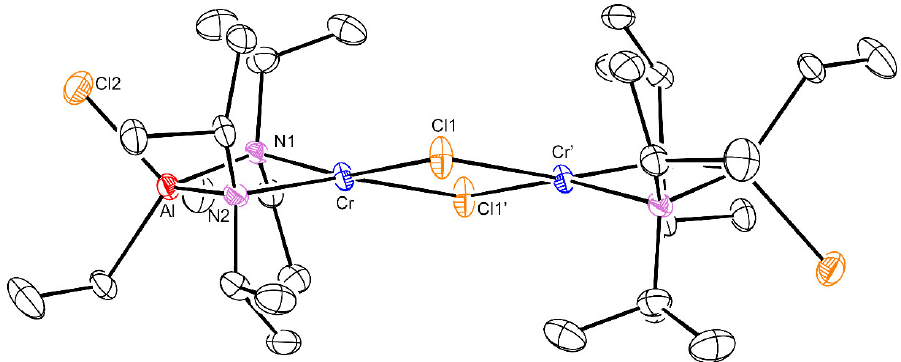
Figure 6. X-ray structure of [{Et(Cl)Al(N(iPr) 2 ) 2 }Cr(μ-Cl)] 2 . Selected bond distances (Å) and angles (°): Cr-Cl1, 2.4212; Cr-N1, 2.141(6); Cr-N2, 2.119(6); Al-N1, 1.925(6); Al-N2, 1.953(6); Al-Cl2, 2.163(3); Cr–Cr’, 3.578(2); N1-Cr-N2, 84.3(2); Cl-Cr-Cl’, 83.96(8); N1-Al-N2, 95.0(3); and angle between N1-Cr-N2 and Cl-Cr-Cl’ planes, 25.1(1).